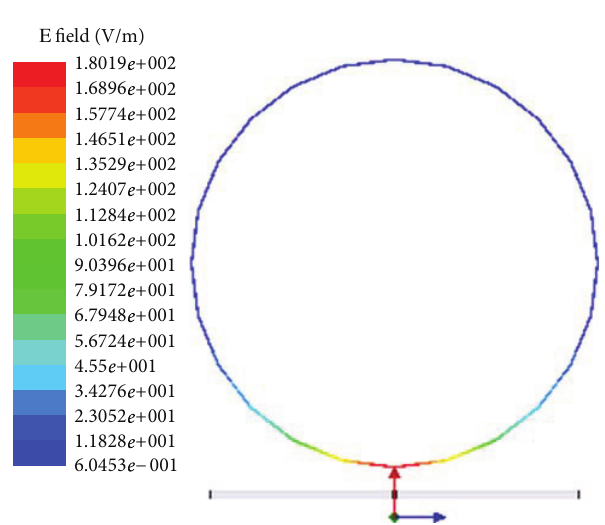
F 13: �-�eld strength in skin tissue at 900MHz.